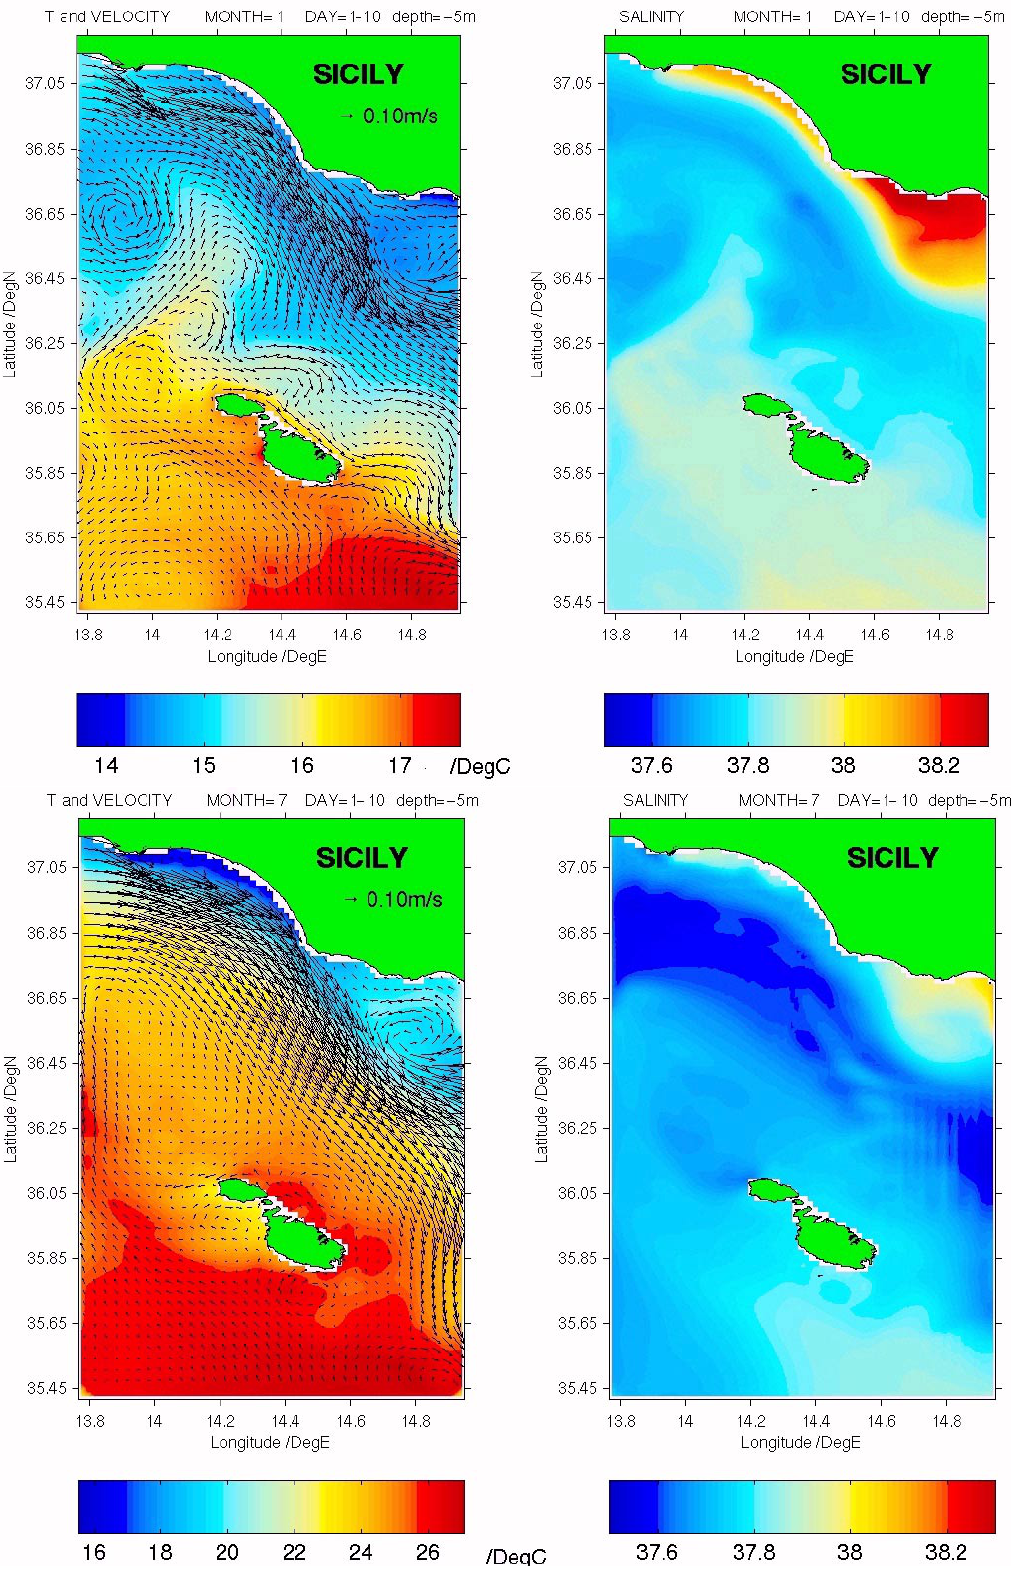
Fig. 14. Ten-day averaged temperature (a) at 5m and total velocity horizontal fields at 30m and (b) salinity at 5m for the second third of January, and of July (c) and (d) . Plotting of velocity vectors is done only at every odd grid